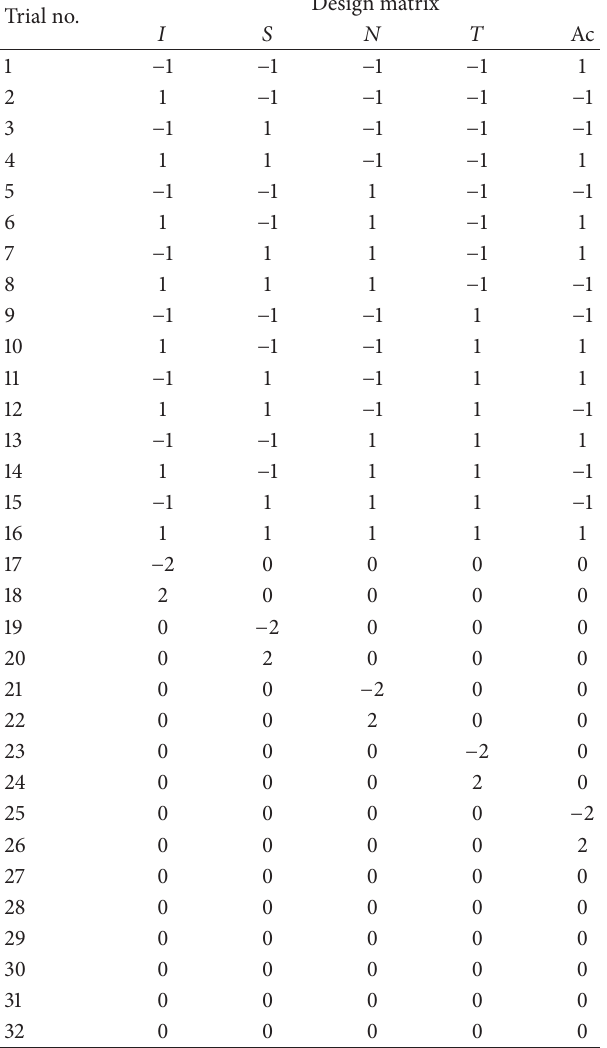
Table 3: Design matrix.